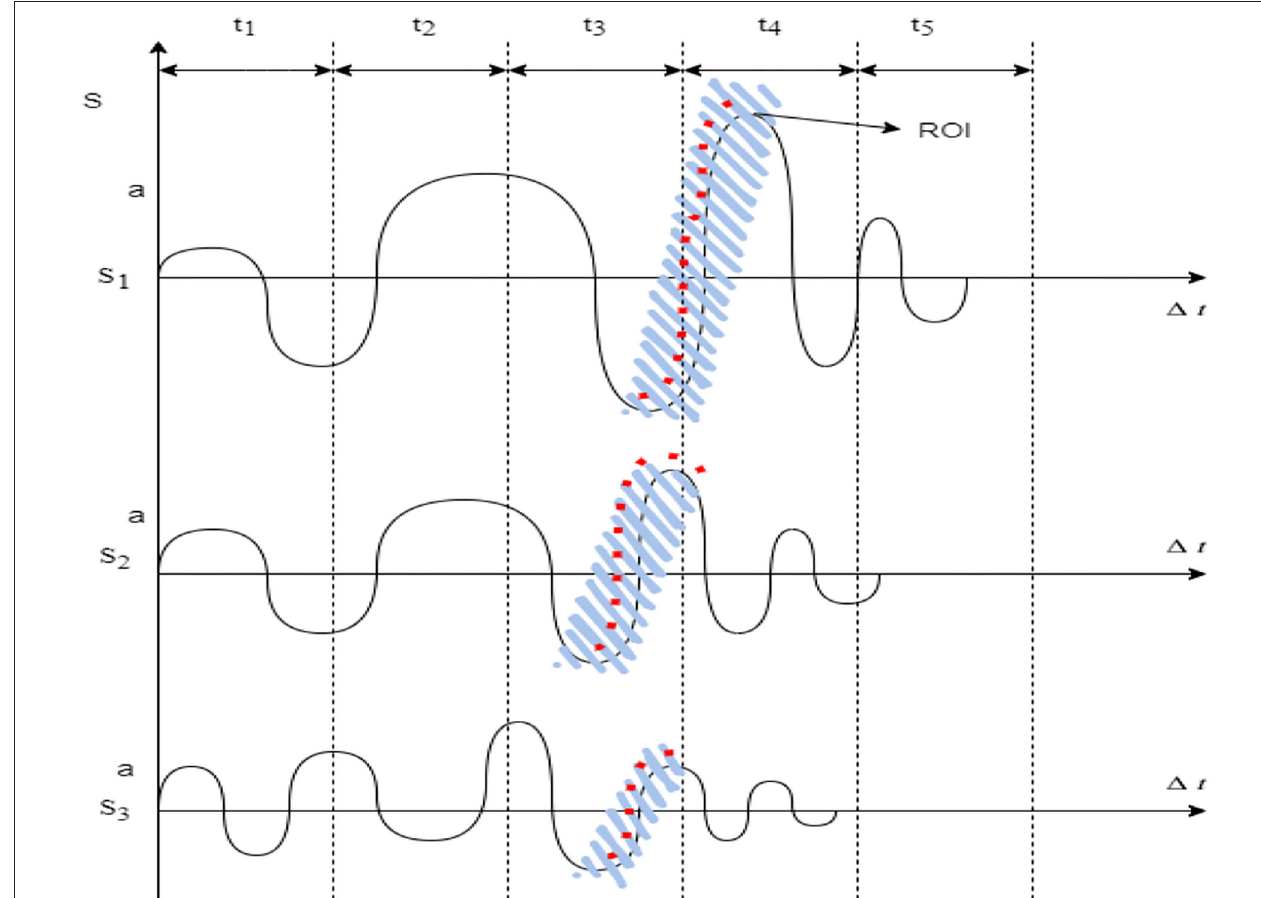
FIGURE 3 | ROI on floating speech samples of multi-users.